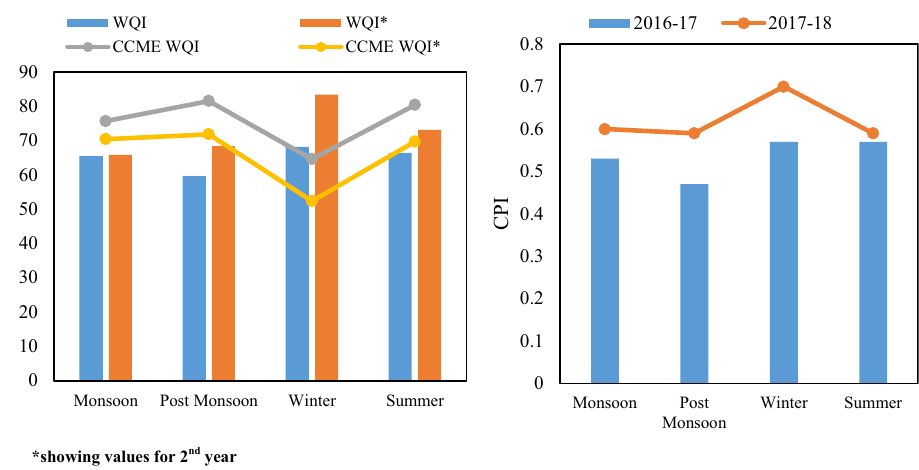
Fig. 3 Plot of WQI, CCME- WQI and CPI showing seasonal variations during both study years * showing values for 2